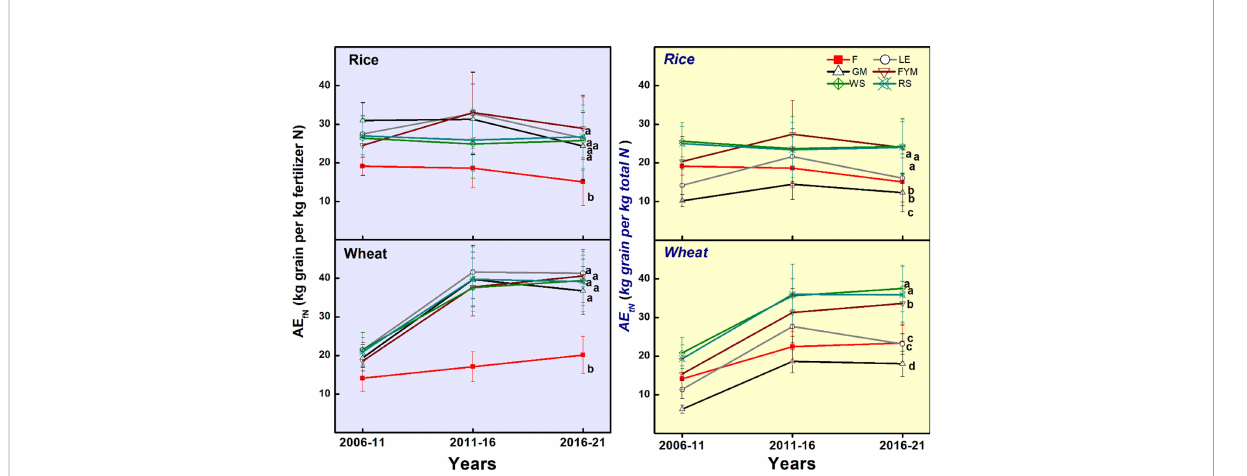
FIGURE 6 Trends in the agronomic ef fi ciency (AE; AE fN based on the chemical fertilizer N applied, and AE tN based on the total N applied from all organic and inorganic sources) of rice and wheat crops during 15 years (2006-2021) of different nutrient management. Error bars denote ± 1SD. Different letters indicate signi fi cant differences (P ≤ 0.05). Refer to Figure 2 for the description of treatments.